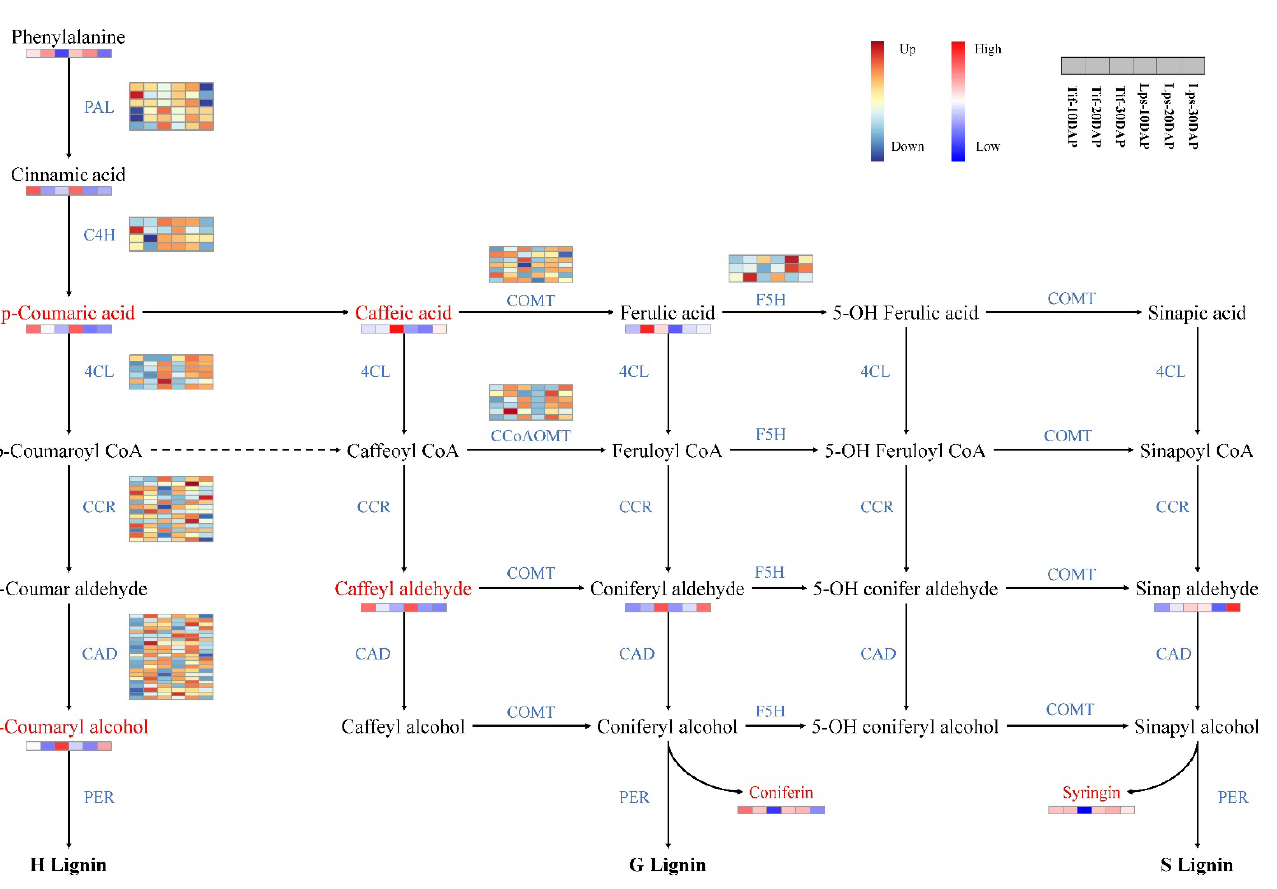
Figure 5. Joint KEGG enrichment p -value histogram of Tif vs. Lps at ( A ) 10 DAP, ( B ) 20 DAP and ( C ) 30 DAP.